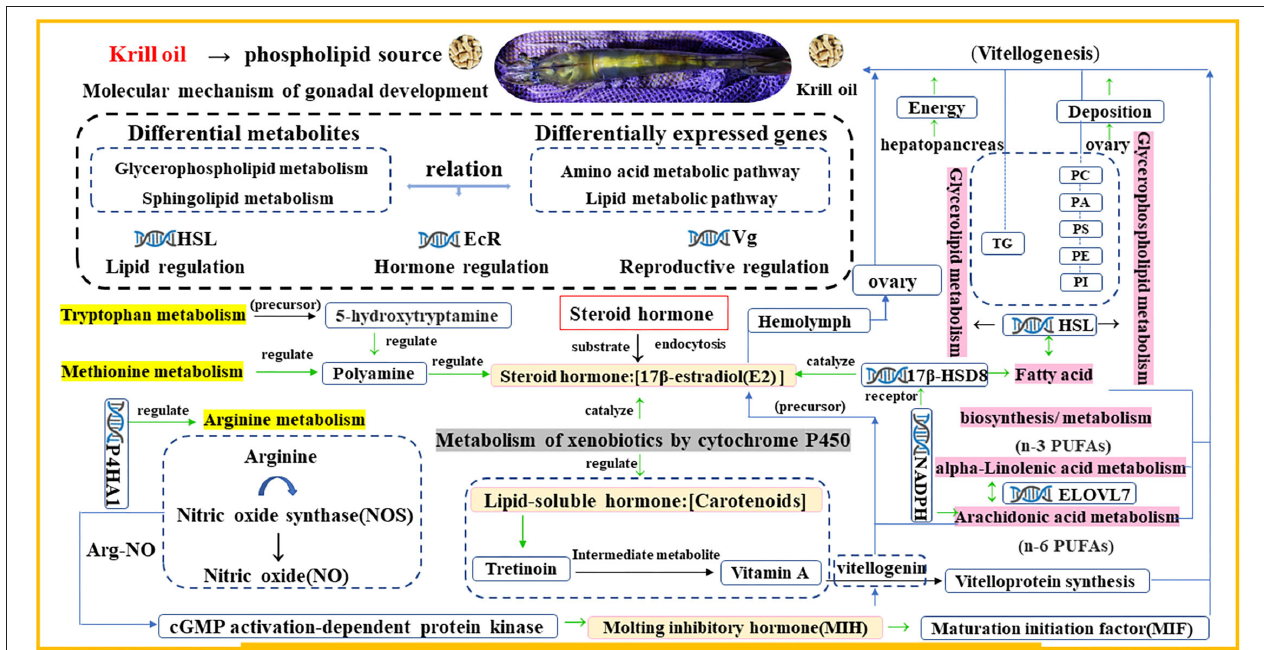
FIGURE 12 | A hypothetical integrated metabolic network of key differential metabolites and genes in significant pathways identified by multiomics analysis after ingestion of krill oil as a phospholipid source of feed based on the KEGG pathway database. The yellow frame represents the metabolism of amino acids. The purple bottom frame represents the metabolism of lipids. The gray bottom box indicates another accessory pathway metabolism. The pink bottom frame represents hormones. The gene symbol represents the hub gene of the pathway. The green arrow indicates the regulation of the downstream. The blue arrow indicates the path